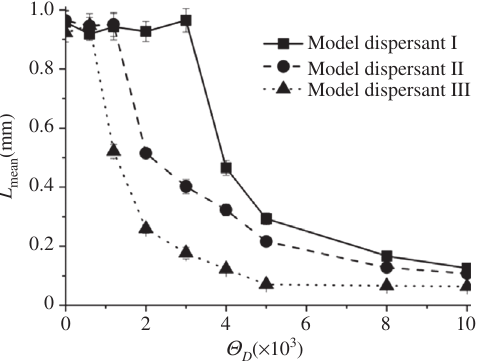
= 0.30 μ l/min and (D) F D